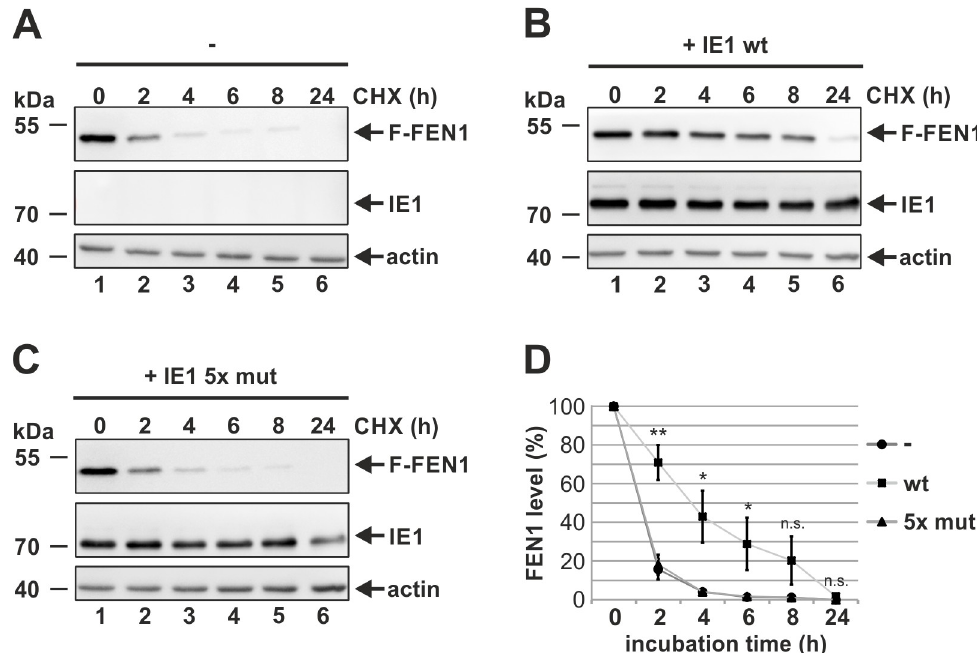
Fig 4. Stabilization of FEN1 by IE1 binding. (A, B, C, and D) 293T cells were transfected with FLAG (F)-FEN1 alone (A) or in combination with either IE1 wildtype (wt) (B) or IE1 5x mut (C). 18 hours post transfection, cells were treated with 10 μ g/ml protein synthesis inhibitor cycloheximide (CHX) and harvested at the indicated times post addition. Western blot analyses were performed to detect FLAG (F)-FEN1, IE1, and β -actin. (D) Decline of FEN1 obtained by three independent experiments is represented by mean values ± SD. The p-values were calculated using two-tailed Student’s t- tests. n.s., not significant; �� , p � 0.01, � , p � 0.05.